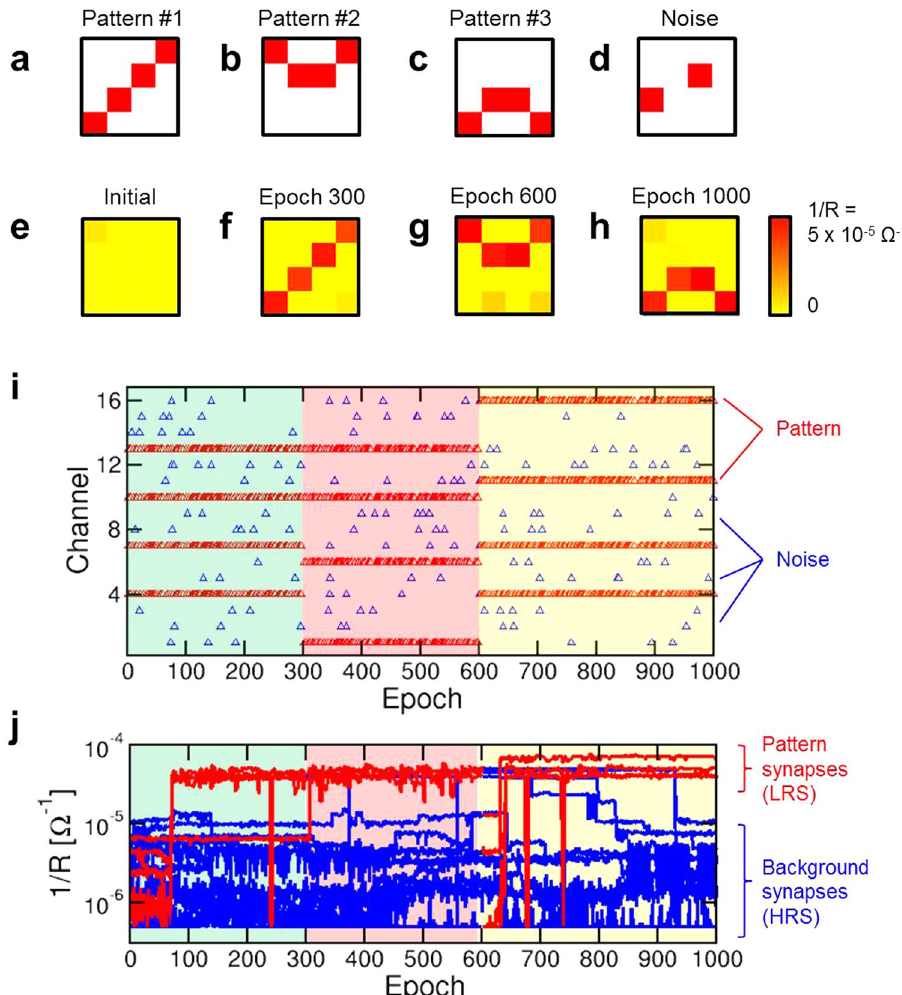
Figure 3. Static and dynamic learning within a 1-POST network. ( a,b,c,d ) Illustration of the pattern #1, pattern #2, pattern #3 and a typical random noise image that were submitted to the PREs during learning. ( e ) Initial configuration of synaptic weights, where all RRAM devices were prepared in HRS. ( f ) Configuration of synaptic weights after 300 epochs (3 s), indicating adherence to pattern #1 that was stochastically submitted during the first 300 epochs. ( g ) Configuration of synaptic weights after 600 epochs (6 s), indicating adherence to pattern #2 that was stochastically submitted during the previous 300 epochs. ( h ) Configuration of synaptic weights after 1000 epochs (10 s), indicating adherence to pattern #3 that was stochastically submitted during the previous 400 epochs. ( i ) Address of the PRE stimulation as a function of time, indicating the submission of the 3 patterns alternated with random noise. ( j ) Measured synaptic weights 1/R as a function of time: pattern weights (red) and background weights (blue) tend to high and low conductance, respectively, thus demonstrating pattern